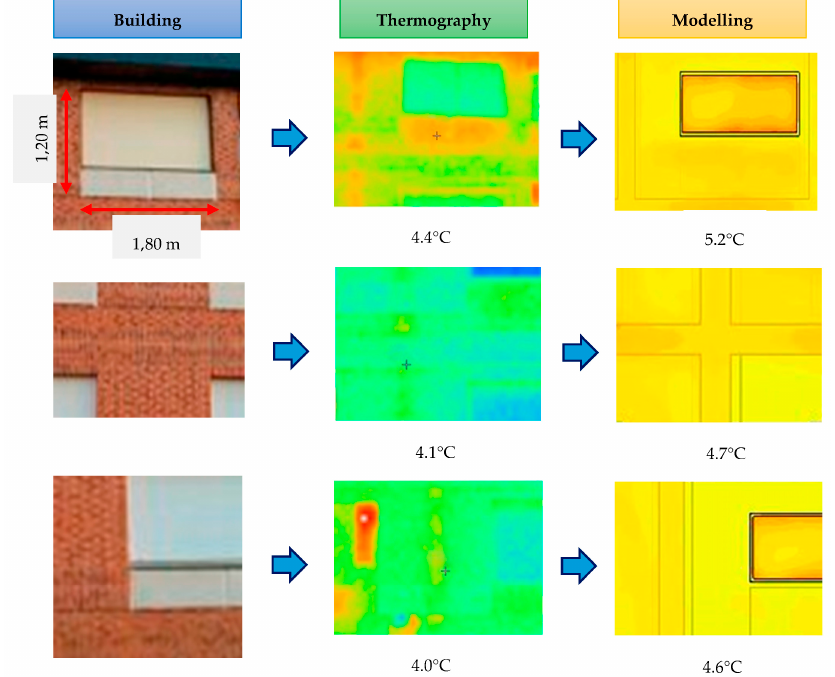
Figure 7. Surface temperature in different points of the facade. Comparison of Thermography and CFD modelling with Star-CCM+ 8.05.006.